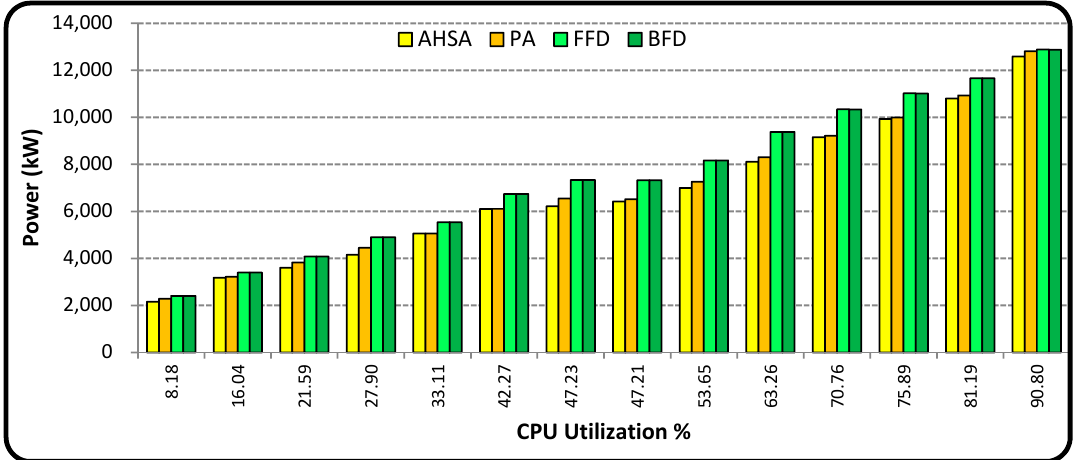
Figure 10. CPU utilization of scenario II for 100% RVA for first 14 cycles.